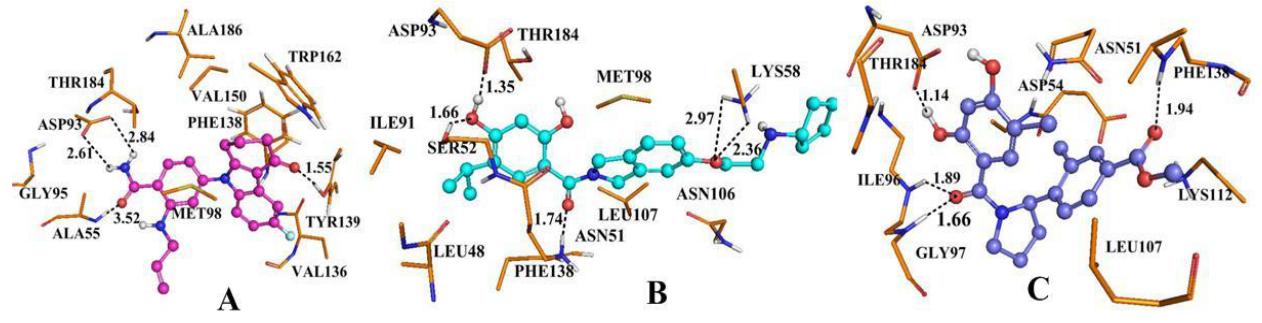
Figure 12. Plot of the MD-simulated structures of the binding site with ligand. H-bonds are shown as dotted black lines; Active site amino acid residues are represented as sticks; the inhibitors are shown as stick and ball model. ( A ) Compound 17 in complex to the active site of Hsp90 enzyme; ( B ) Compound 24 with the binding site of Hsp90; ( C ) Compound 19 with the allosteric binding site of Hsp90